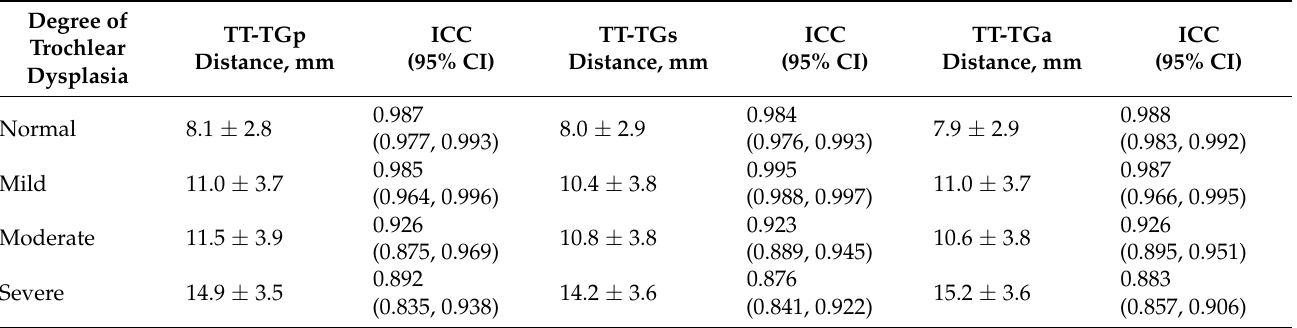
Table 6. Inter-observer reliability of the TT-TG distance in different Oswestry-Bristol Classification of trochlear dysplasia a .